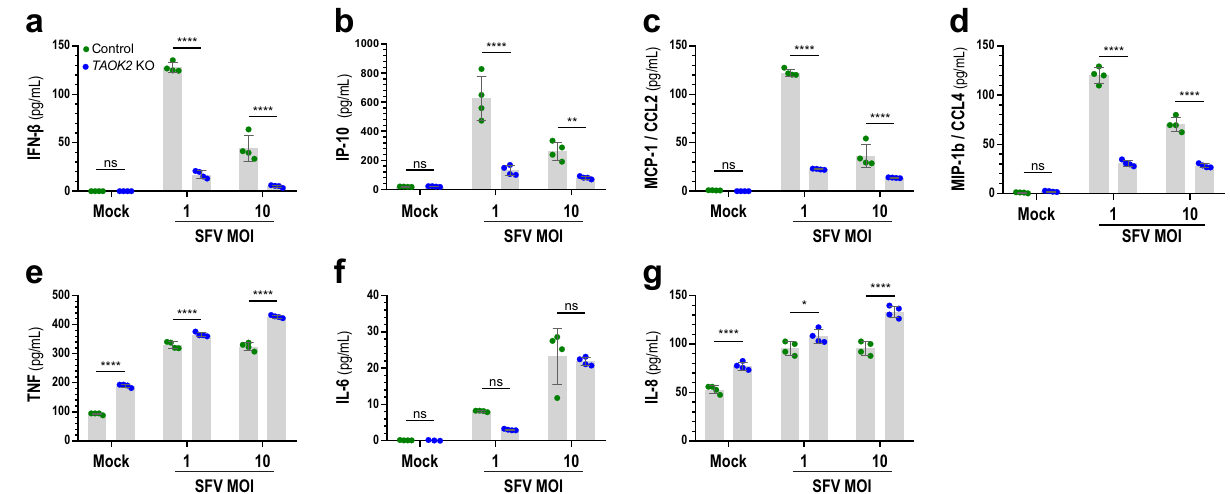
Fig. 7 Loss of TAOK2 directly impacts IFN- α / β secretion. a – g THP-1 control (green) or TAOK2 KO (blue) cells were infected with SFV at the indicated MOI and 24 h later the accumulation of cytokines in the supernatant was measured by ELISA (IFN- β ( a ) and IP-10 ( b )) and cytometric bead array (MCP-1/ CCL2 ( c ), MIP-1b/CCL4 ( d ), TNF ( e ), IL-6 ( f ), and IL-8 ( g )). Data presented is averaged across four biological repeats with mean ± SD. **** p < 0.0001, *** p < 0.001, ** p < 0.01, * p < 0.05, ns p > 0.05 (Two-way ANOVA with Š ídák ’ s multiple comparison test). Source data are provided as a Source Data fi not induce MX1, while expression of MX1 was similar in both TAOK2 KO and control cells (Fig. 6b) indicating that signaling